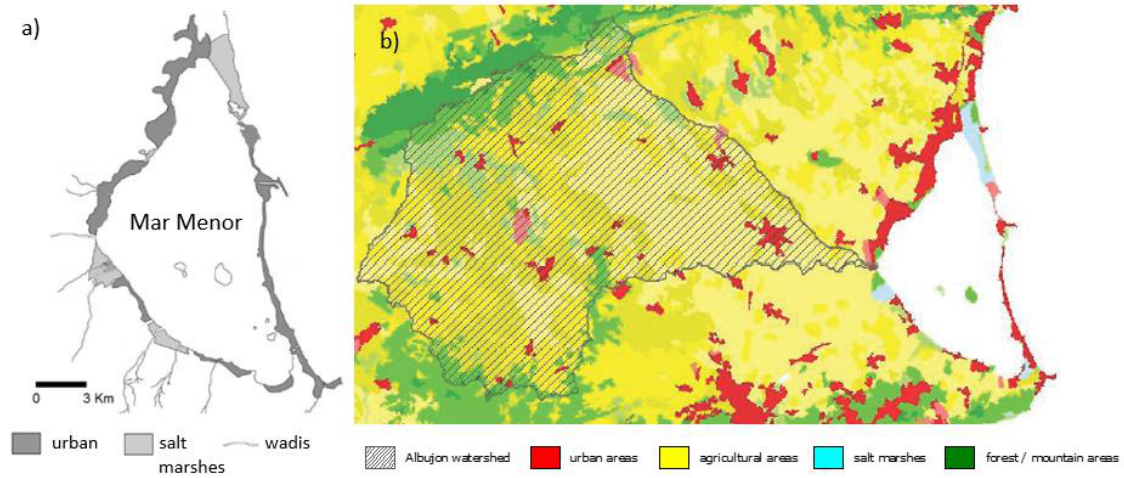
Figure 4. ( a ) Wadis going to the Mar Menor lagoon. ( b ) Watershed nourishing Albujon wadi.